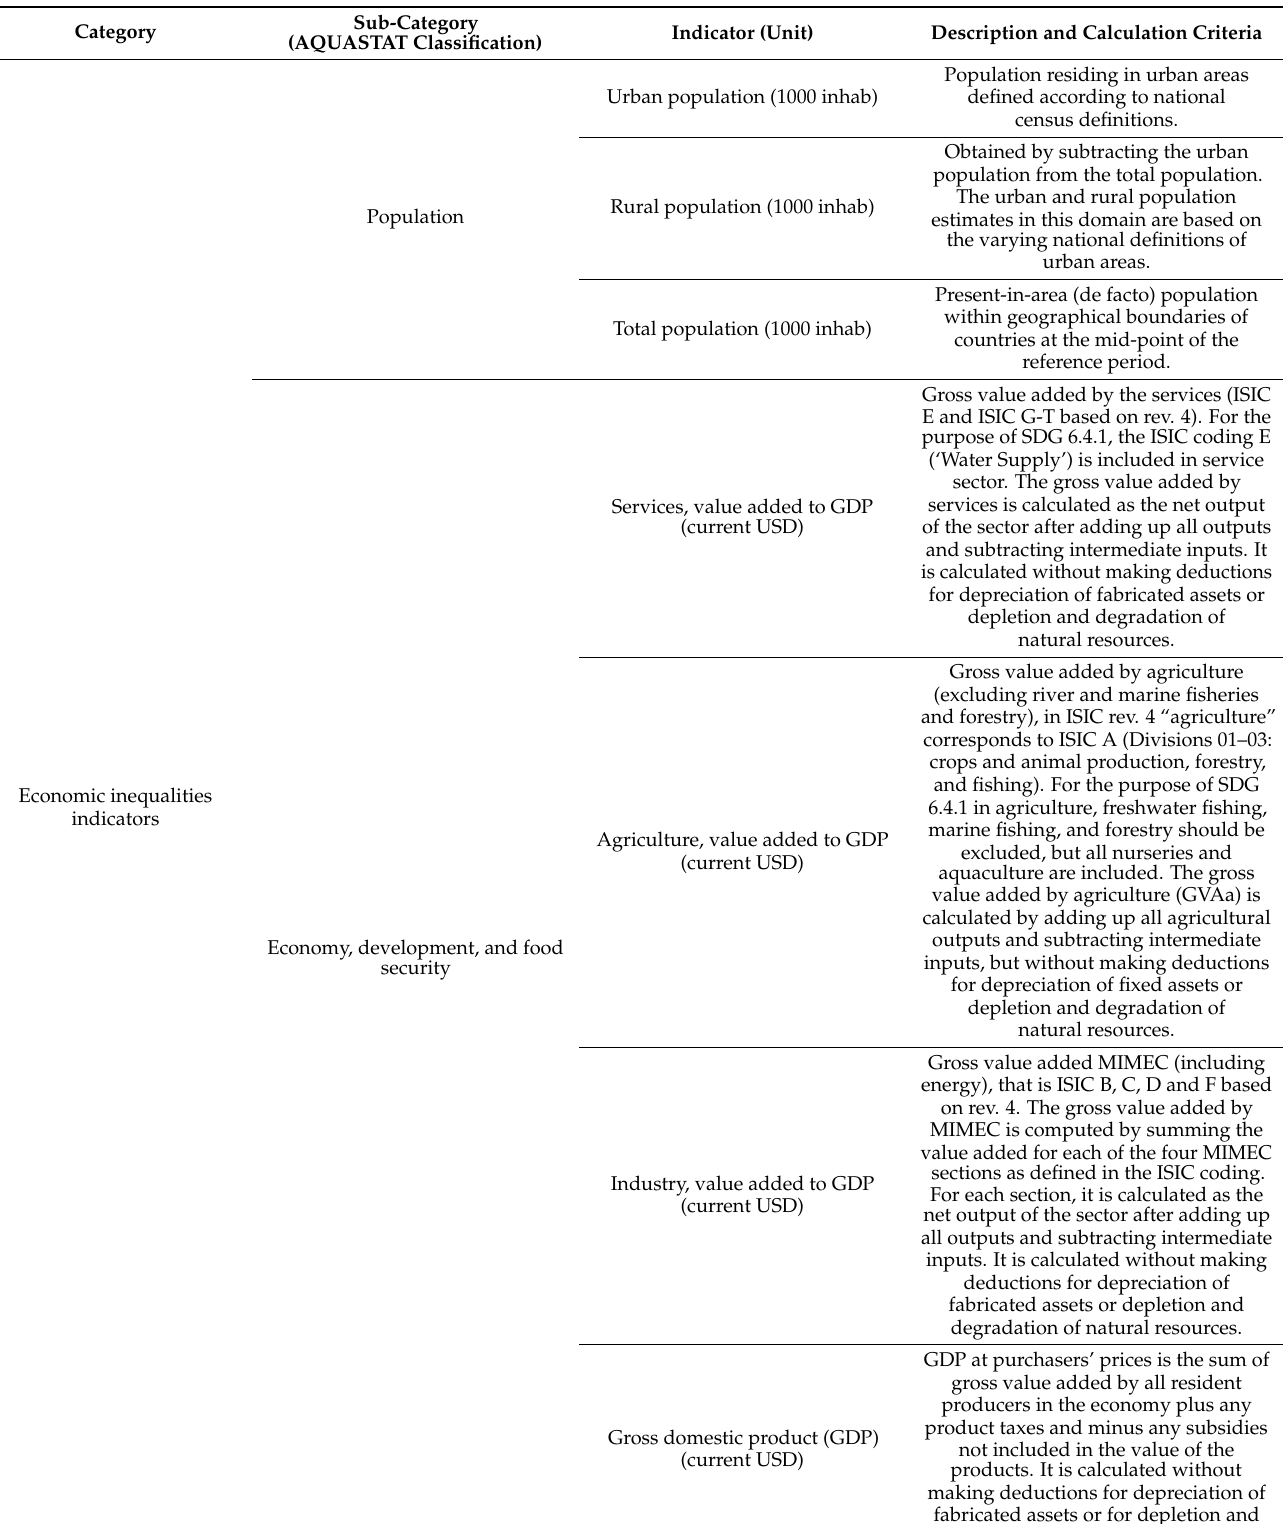
Table 1. AQUASTAT indicators and their descriptions according to the categories used in QESW. Source: adapted from AQUASTAT database